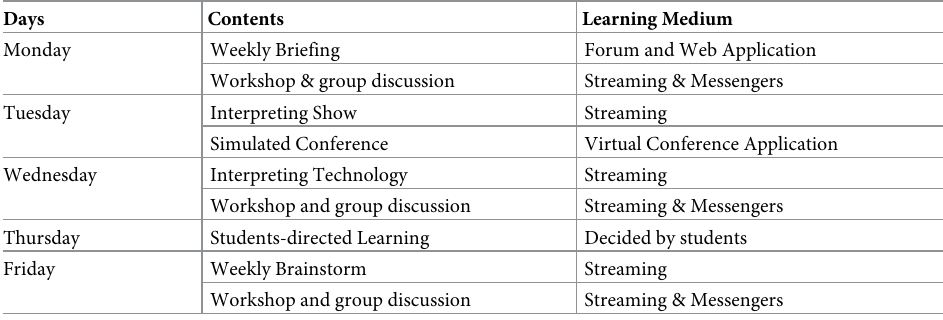
Table 2. Weekly schedule for informal learning community.